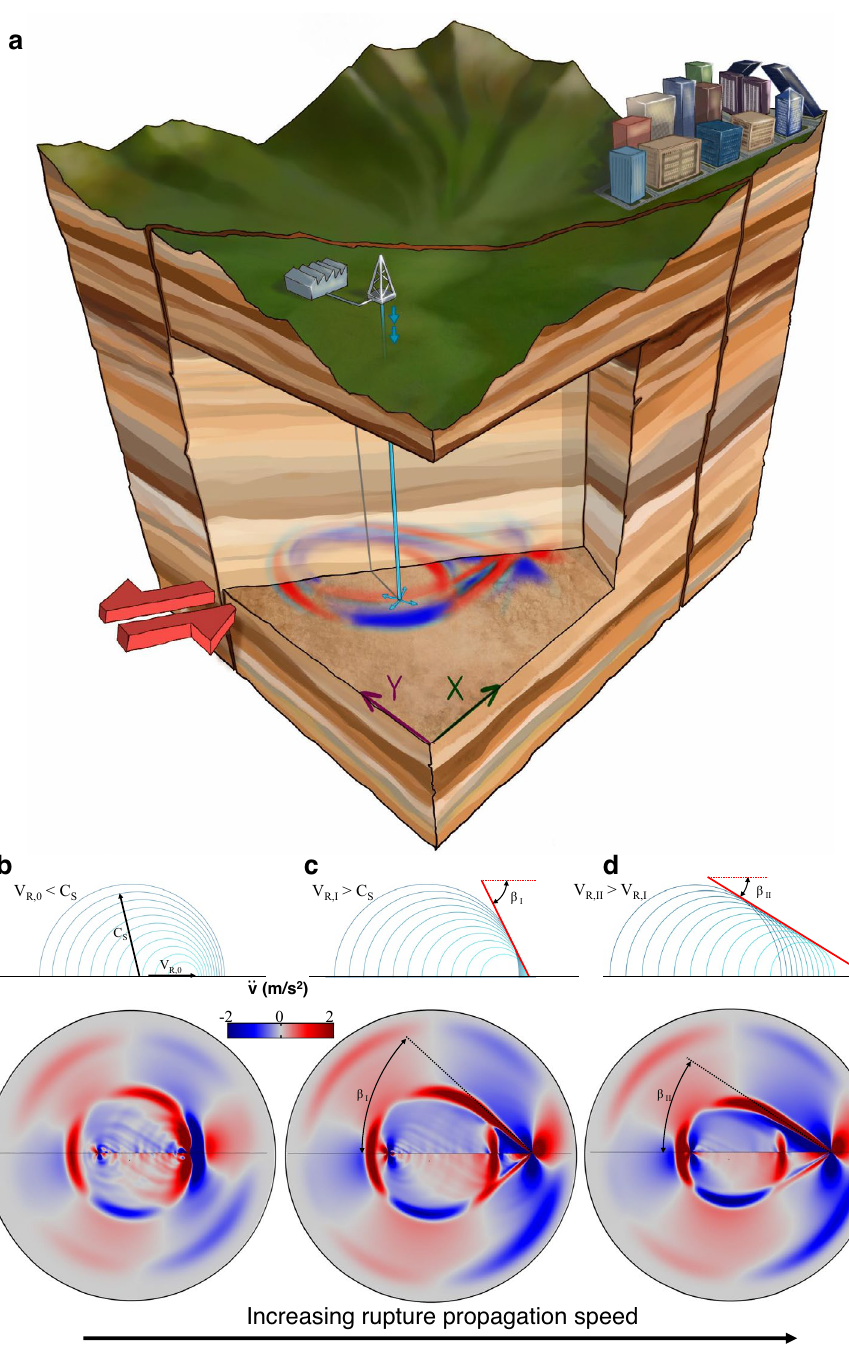
Figure 1. ( a ) We simulate earthquake ruptures on a velocity-weakening strike-slip fault, and study the impact of rock-fluid coupled responses on rupture speed (see Supplementary Information). ( b – d ) Solid acceleration patterns reveal the transition from sub-Rayleigh to supershear rupture. In supershear earthquakes, a Mach cone emerges behind the propagating rupture front (illustrated here through snapshots of the solid accelerations at a horizontal plane in c and d ). Above each plot of accelerations, we show a conceptual description of the superposition of radiating waves during sub-Rayleigh ( b ) and supershear ( c and d )